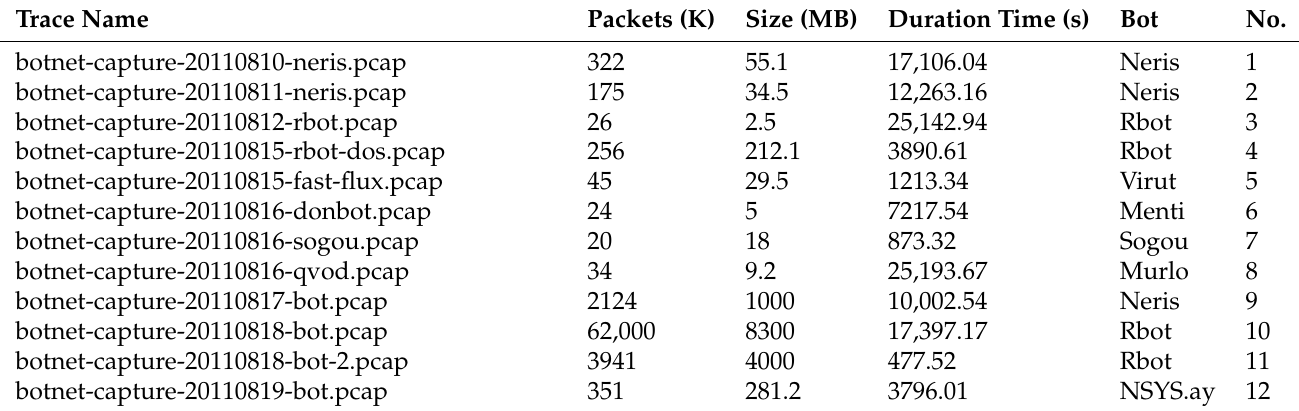
Table 2. Summary of the malicious network traces.